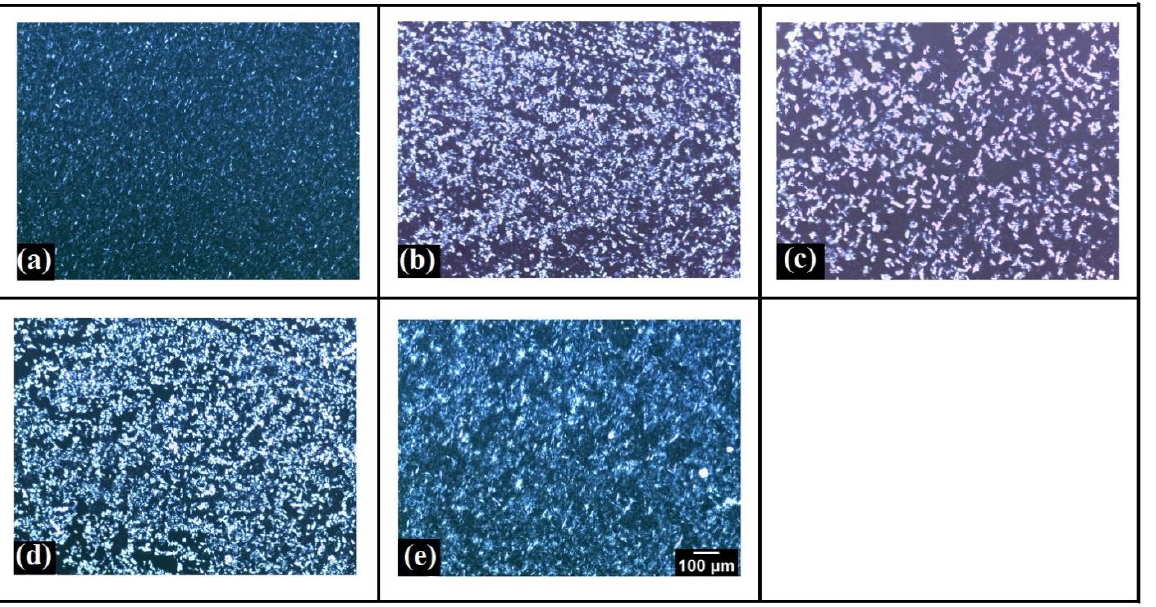
Figure 3. Polarized light micrographs: ( a ) SE0, ( b ) SE1, ( c ) SE3, ( d ) SE5, and ( e ) SE10.